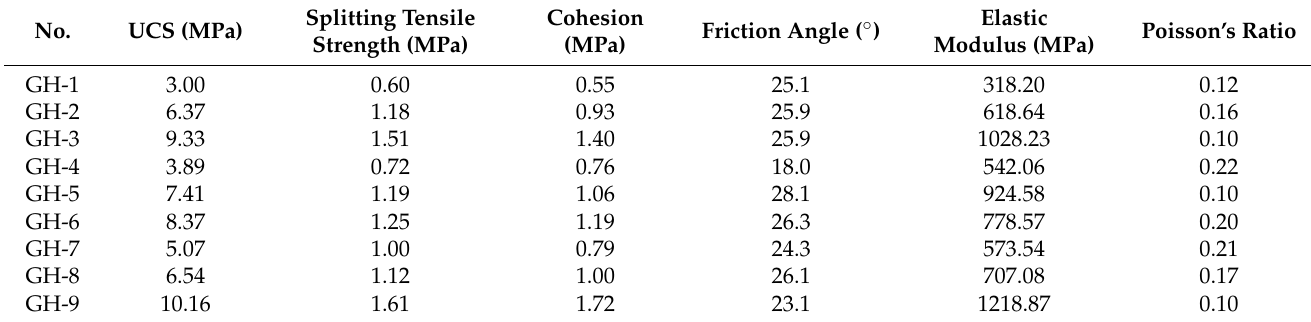
Table 7. Test values of mechanical parameters of gangue paste materials.